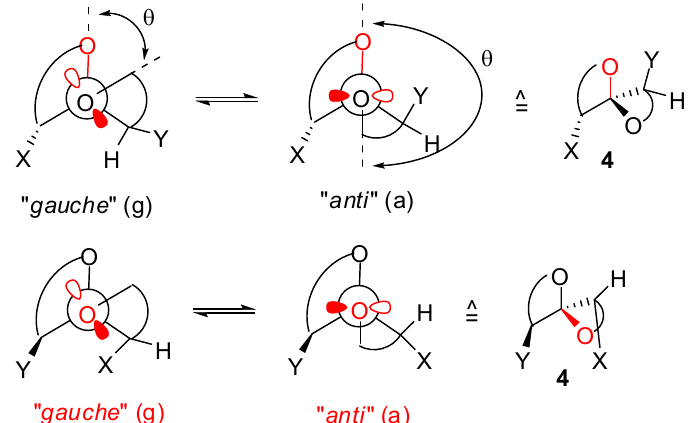
Figure 4. Possible conformers for diastereoisomeric [n,m]-spiroketals (n,m >